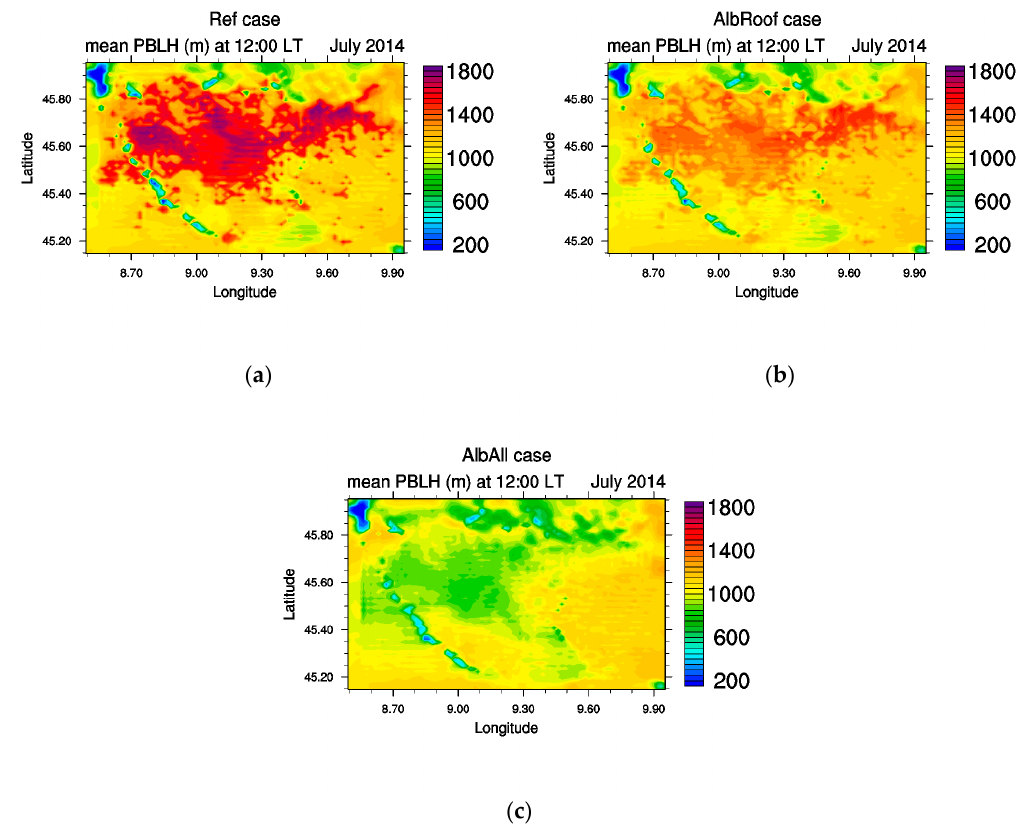
Figure 4. Maps of the mean planetary boundary layer (PBL) height (m) over the highest resolution domain case at 12:00 LT for: ( a ) the reference; ( b ) the test case AlbRoof; ( c ) the test case AlbAll.